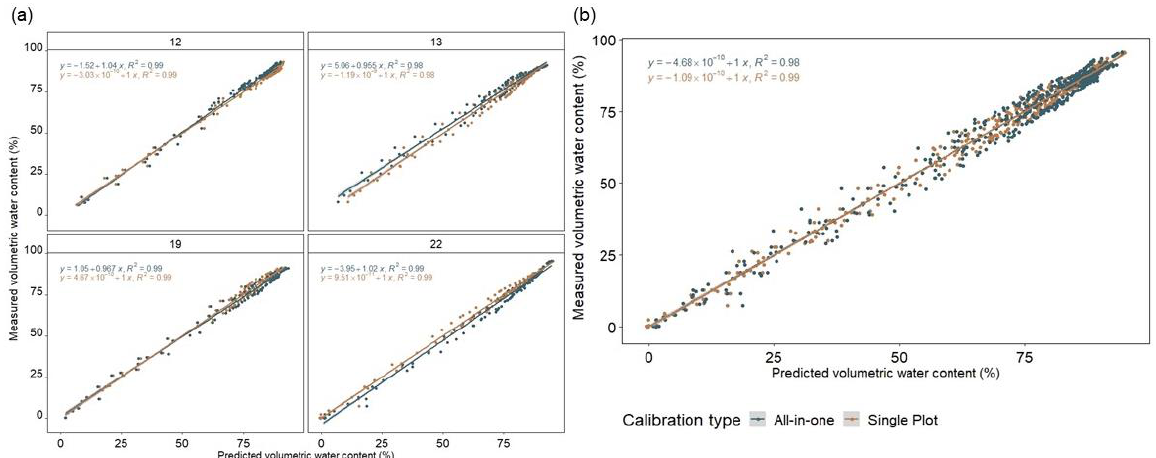
Figure 2. Plot-based (‘single’, brown) vs. whole-site (‘all-in-one’, blue) calibration outcomes and performance as compared to the corrected and measured values for ( a ) individual plot and ( b ) across plots.